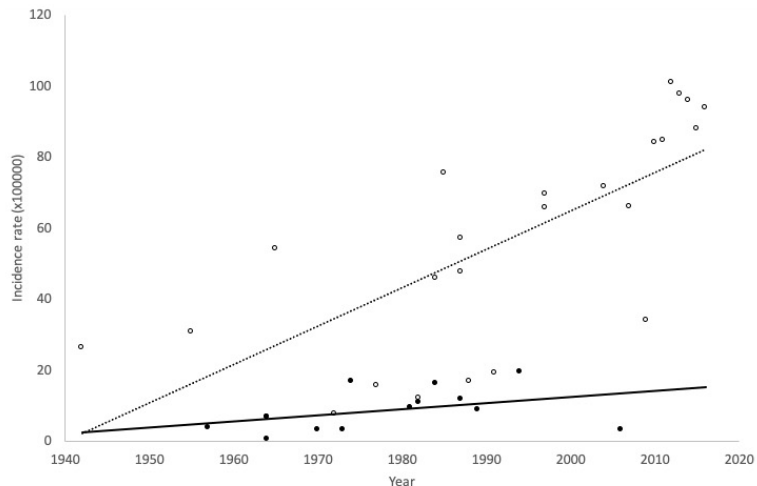
Figure 7. Trends in the incidence of anorexia nervosa in young women for hospital admission (HA) studies (Black circle and continuous line) and outpatient healthcare services (OHS) studies (White circle and dotted line).